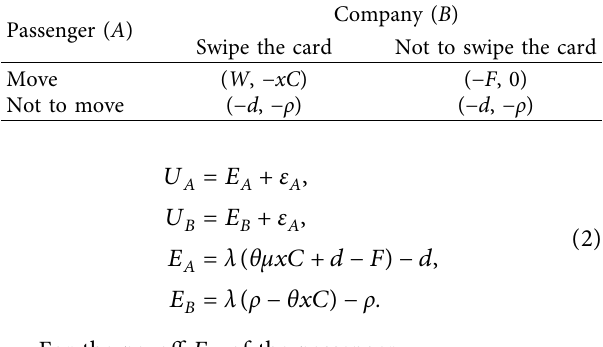
Table 2: Payoffs of the metro passenger and